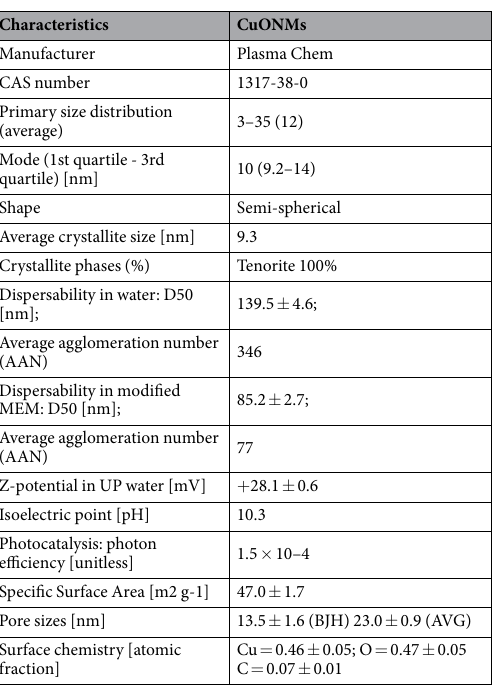
Table 1. Characteristics of the tested CuONMs (Source: FP7-SUN (Sustainable Nanotechnologies European Commission funded